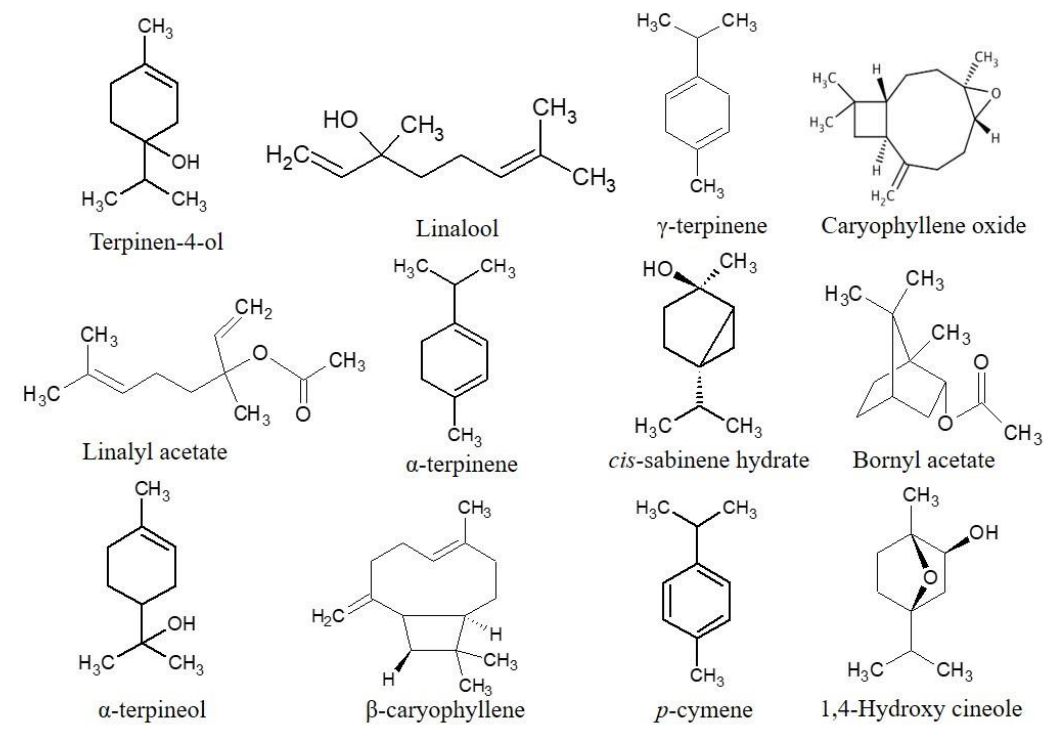
Figure 2. Major chemical constituents identified in the essential oil of Origanum majorana L. (Sample S 1 and Sample S 2 ) and the chiral compounds present, such as terpinen-4-ol, cis - sabinene hydrate, linalool, linalyl acetate, bornyl acetate, α - terpineol and β -caryo- phyllene in both